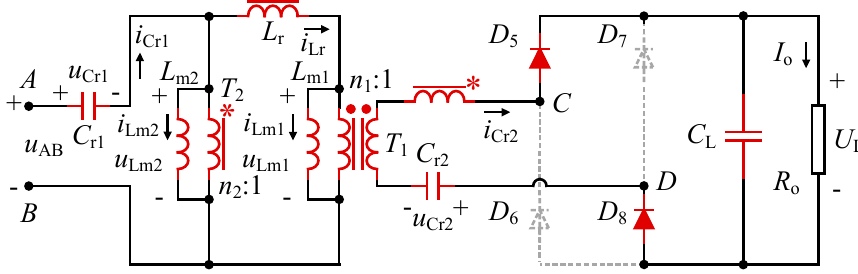
Figure 9. Topology decomposition in forward mode without synchronous rectification strategy.